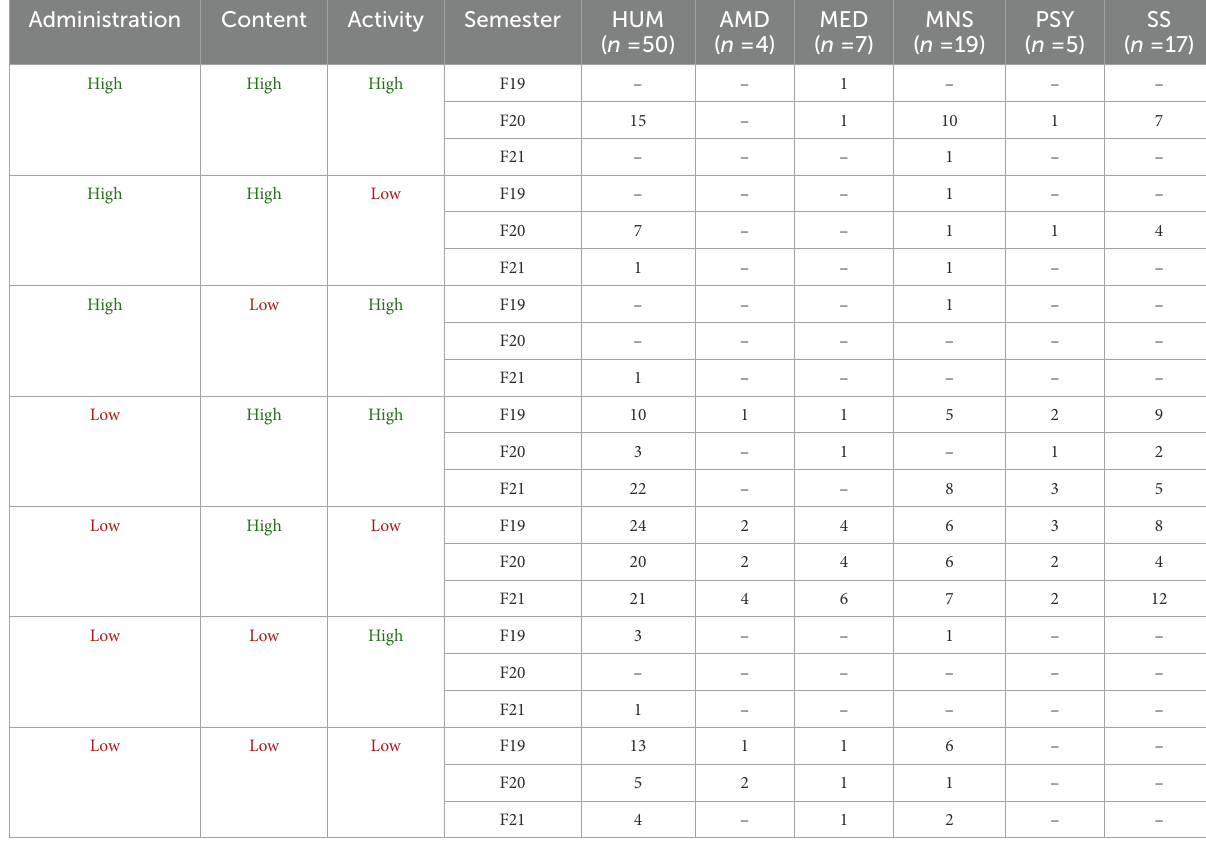
TABLE 9 Frequency of course types by semester and faculty.